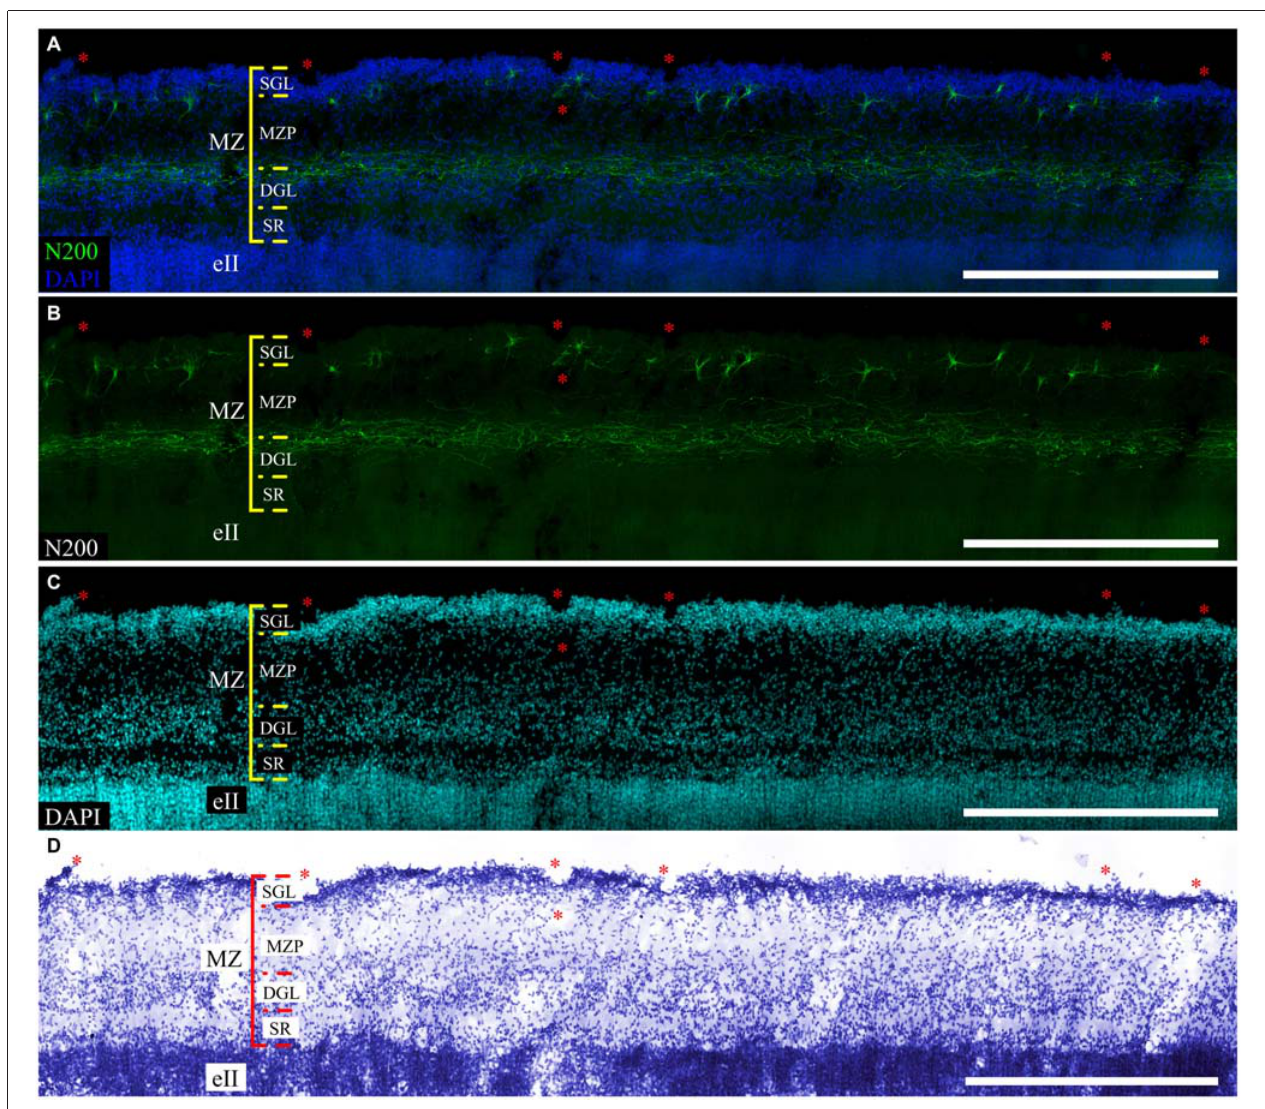
FIGURE 6 | Localization of the N200-positive C–R cells and plexus in MZ at GW 26 . (A–C) —Plexus and C–R cells stained for N200 with the monoclonal antibody (green), DAPI (blue (A) , cyan (C) ) frozen section. (D) —re-staining the same slice with the Nissl method. ( ∗ ) fiducial points. Scale bars: (A–D) 500 µ